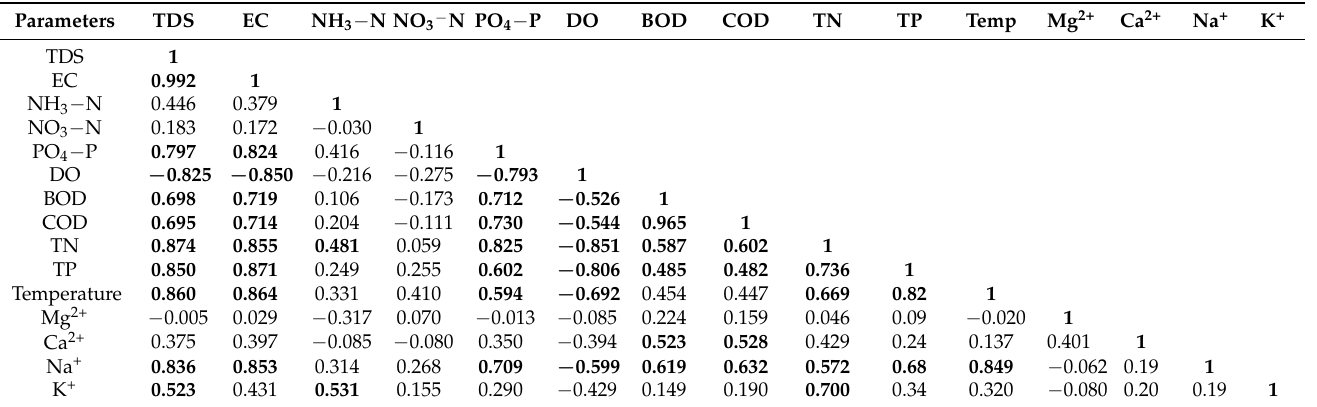
Table 4. Correlation matrix Pearson (r) and alpha (p) values for the wet